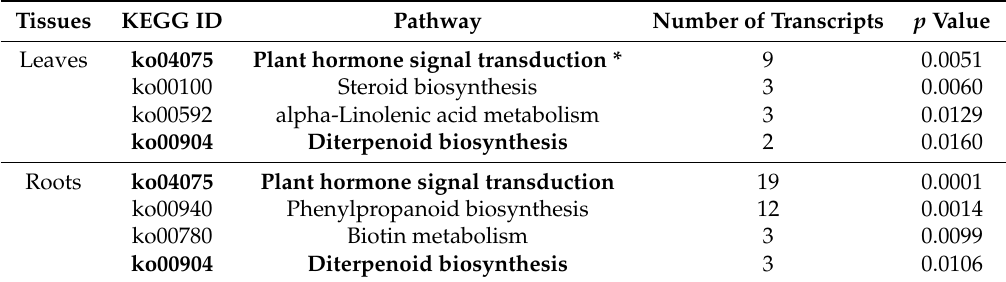
Table 3. List of significant pathways identified by Kyoto Encyclopedia of Genes and Genomes (KEGG) enrichment analysis of DEGs in the leaves and roots. Note: The common pathways were in